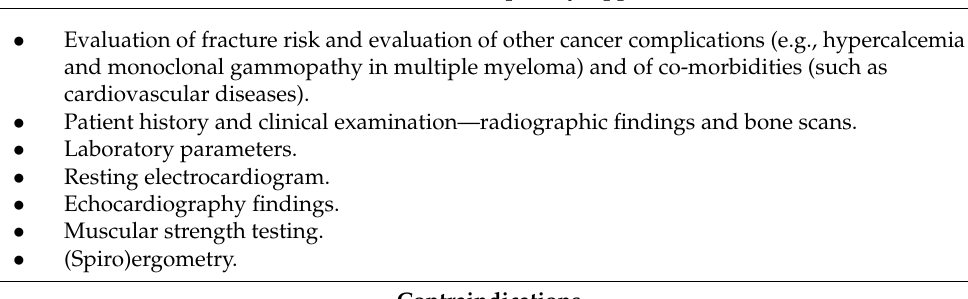
Table 1. Assessment and contraindications for exercise in patients suffering from metastatic bone disease or multiple